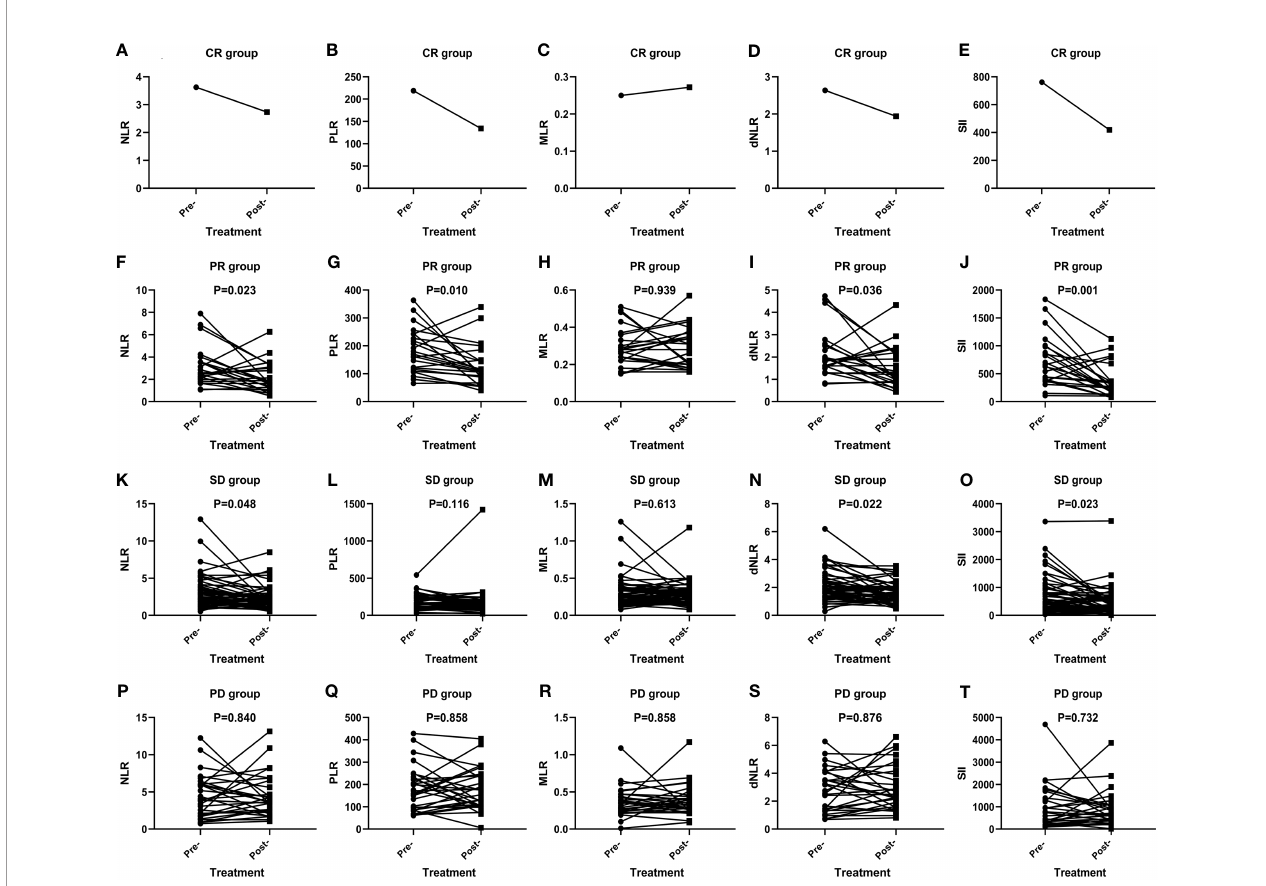
FIGURE 1 | Ef fi cacy of anti-PD-1 treatment according to the changes in in fl ammatory markers in AGC patients in the CR group (A – E) , PR group (F – J) , SD group (K – O) , and PD group (P – T)